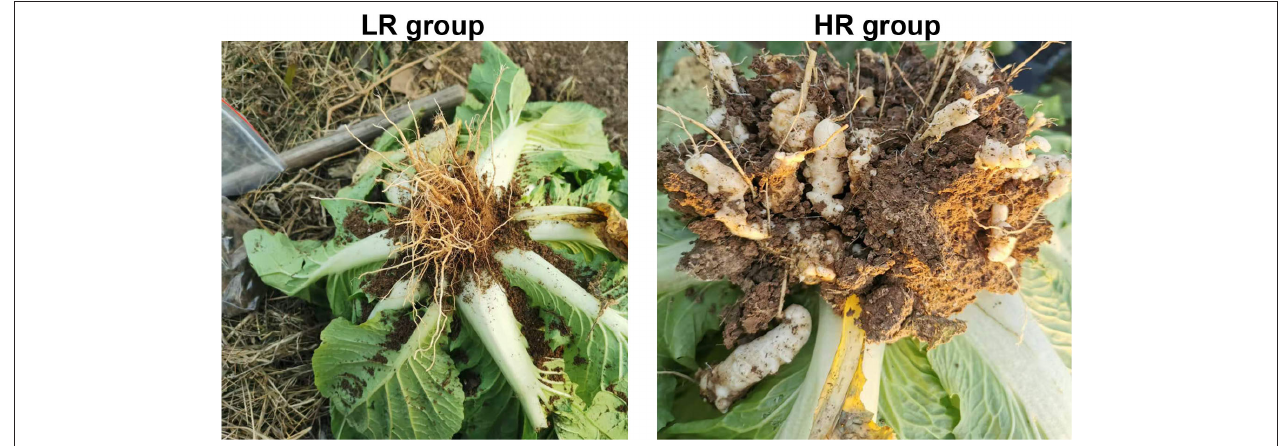
FIGURE 1 | The morphology of the cabbage roots in the LR (left) and HR (right) groups.